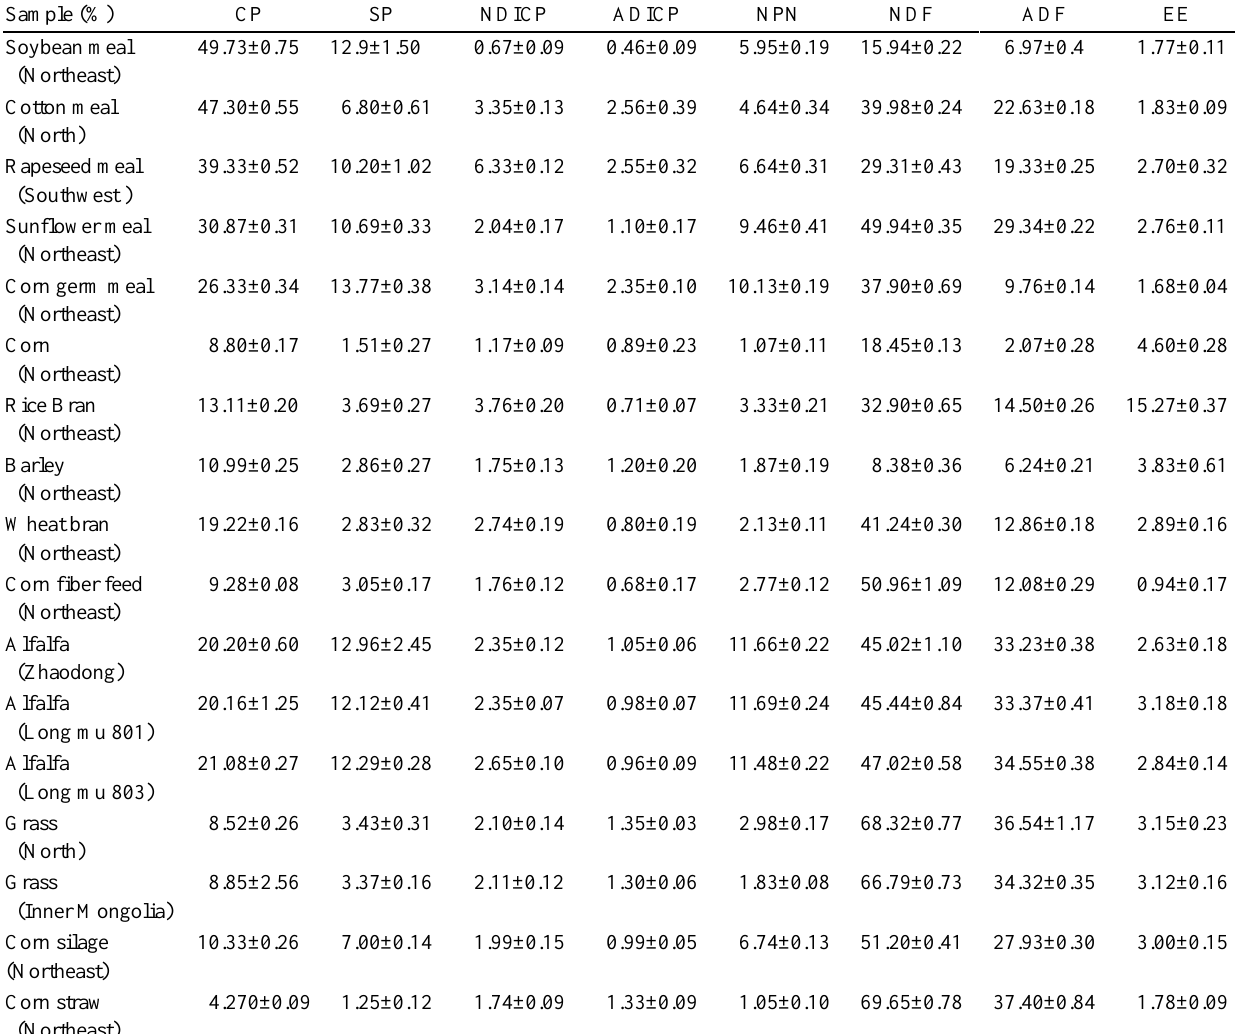
Table 1. Determined samples nutrients content of protein supplements (DM basis) Sample